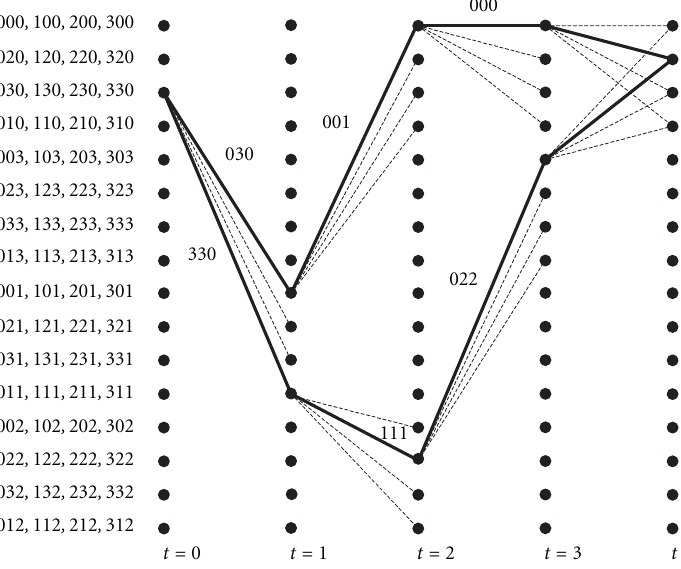
Figure 1: Example ST code for three antennas,